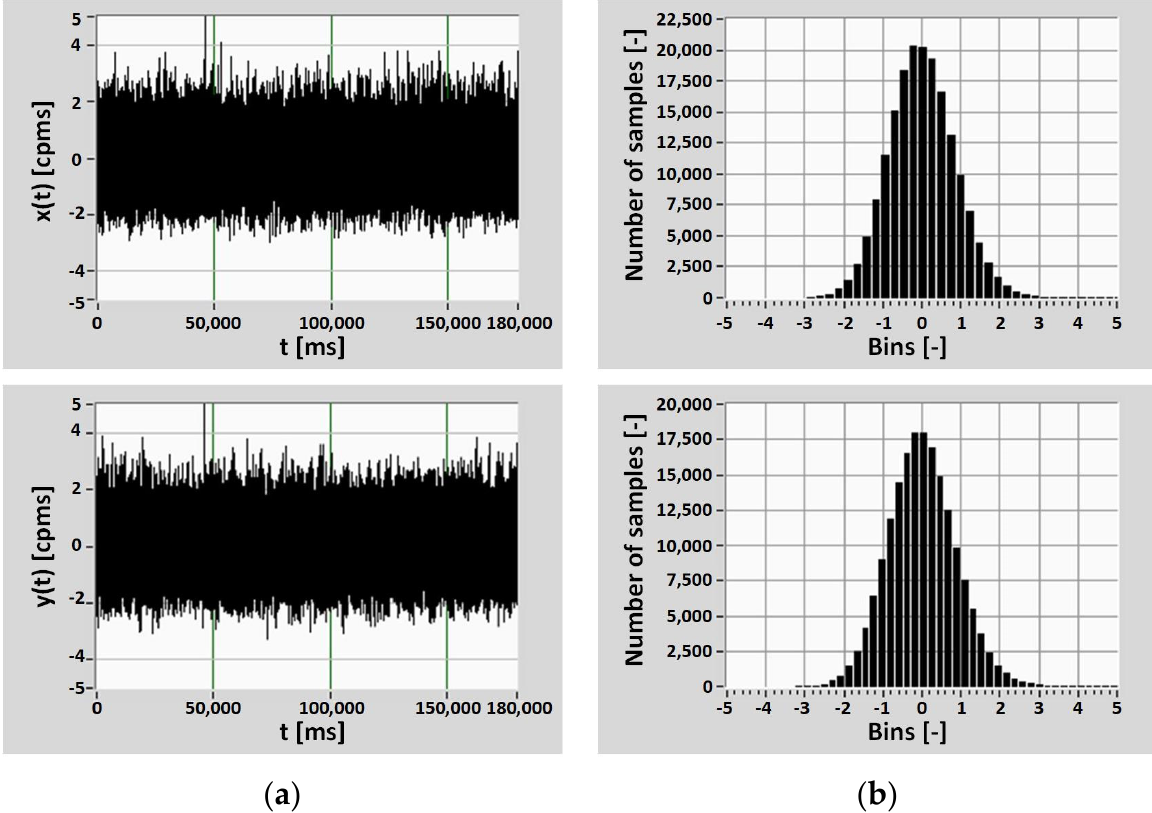
Figure 5. Recorded signals ( a ) and their histograms ( b ) obtained in the experiment WRQ30.